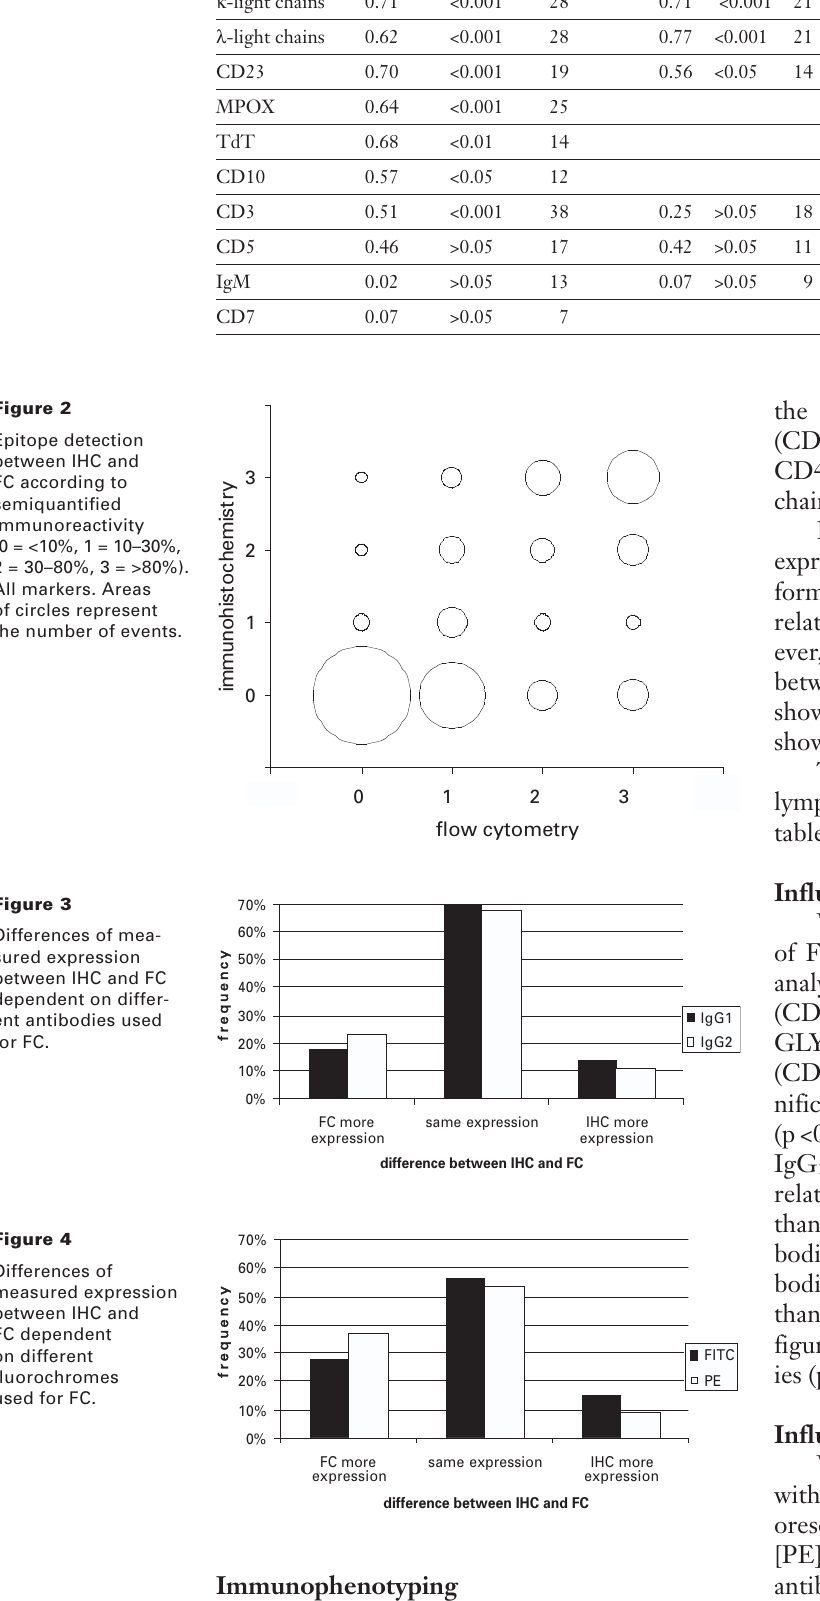
Regression analysis between semi-quanti- fied marker-expres- sion as measured by IHC and